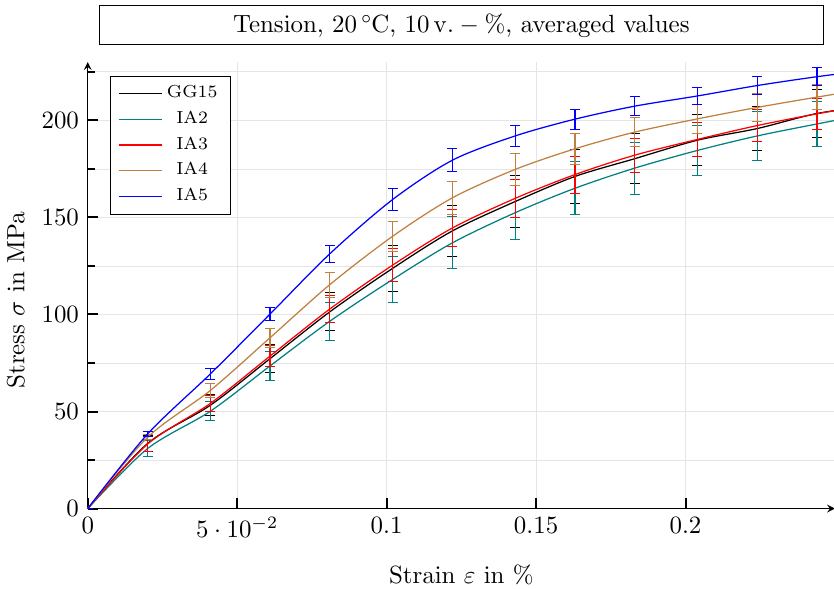
Figure 9. Influence of the graphite class on anisotropy, with a constant domain size and graphite vol- ume fraction. The macroscopic stress–strain characteristics averaged over three variants of a graphite class are shown. The corresponding standard deviations of the various graphite morphologies are given as error